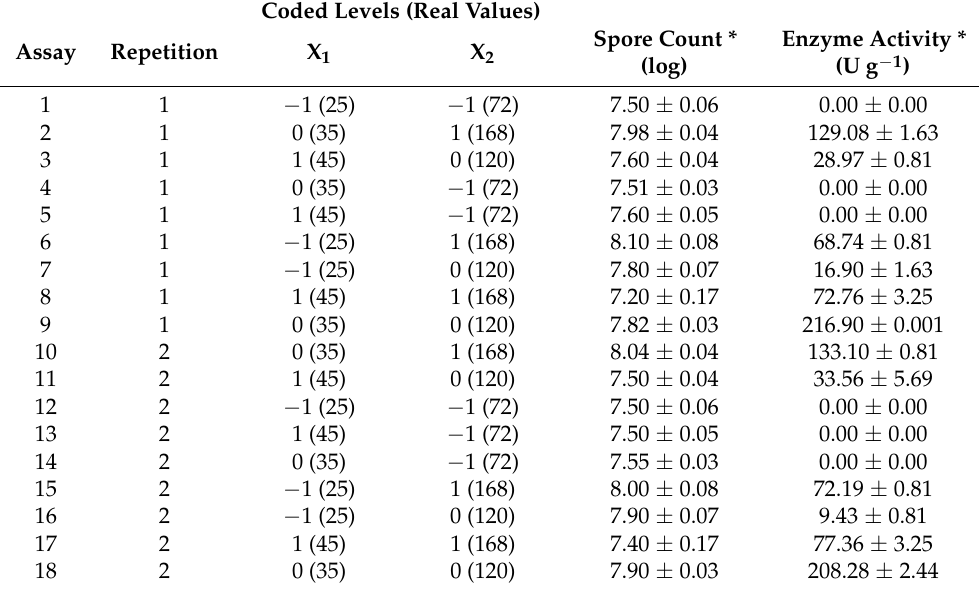
Table 2. Experimental design to evaluate the effects of the independent variables temperature ( ◦ C) and fermentation time (h) on spore count (log) and enzyme activity (U g − 1 ) of the lipase produced from Aspergillus terreus NRRL-255 by solid-state fermentation (SSF). Coded Levels (Real Values) Spore Count * Enzyme Activity Assay Repetition X 1 X 2 (log)